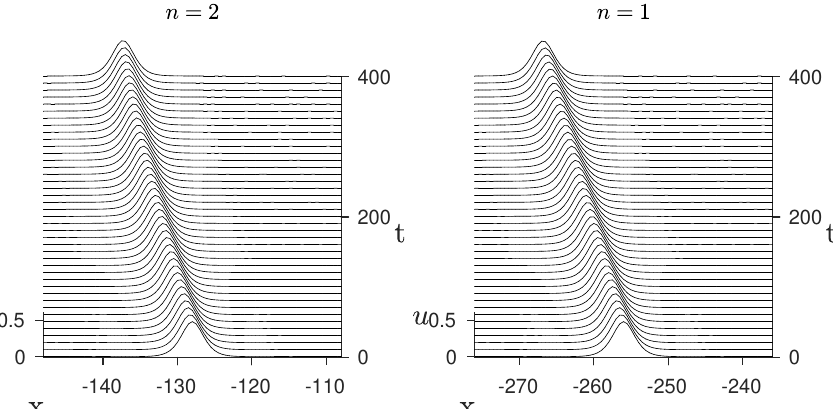
Figure 6. Solitary wave solutions over the periodic forcing. Parameters: ∆ = − 2 a , x 0 = − π /2 q , A = − 1.